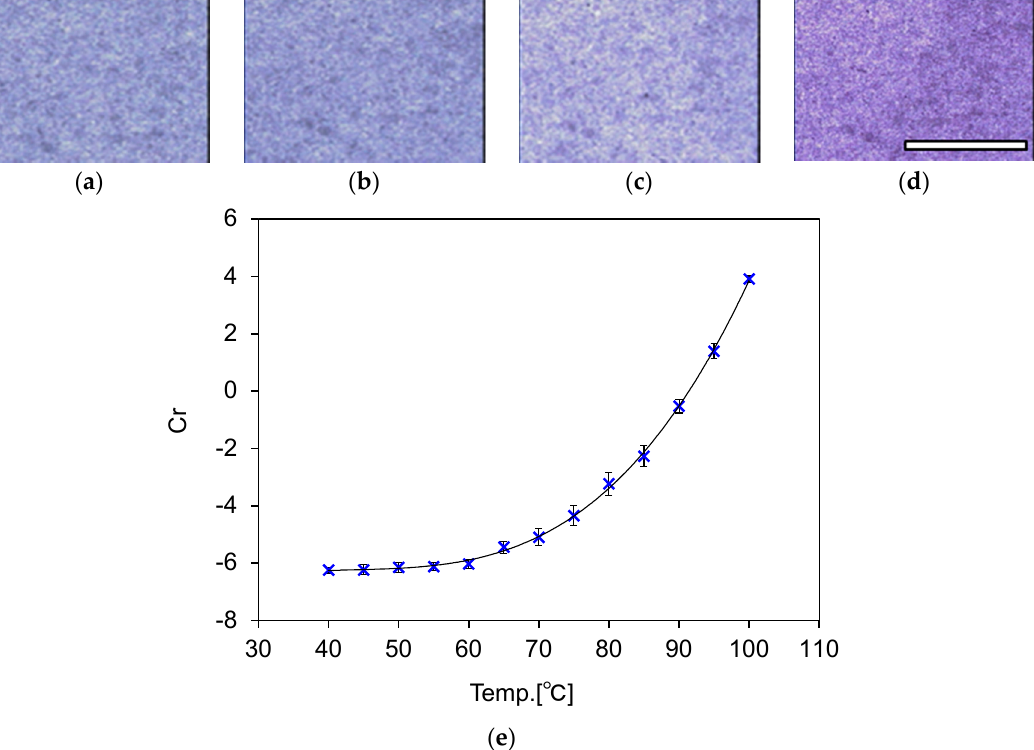
Figure 2. Color change of the composite material. Microscopic images of sheet samples of the composite material after heating at various temperatures. ( a ) 40 °C, ( b ) 60 °C, ( c ) 80 °C, and ( d ) 100 °C. Scale bar = 5 mm. ( e ) Calibration of temperature with Cr values. The solid line indicates the fitting curve of Equation (2).